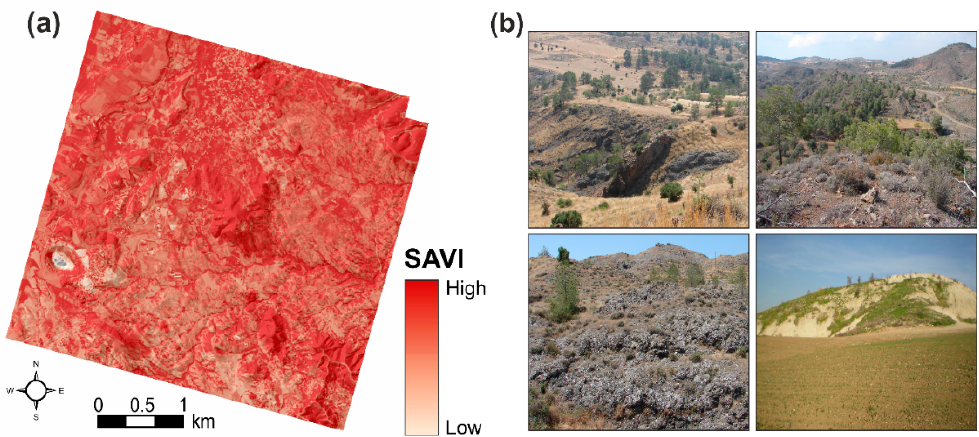
Figure 2. Widespread vegetation cover within the study area: ( a ) soil-adjusted Vegetation Index (SAVI) map indicating relative fractional vegetation abundance; and ( b ) field photographs illustrating the different types of vegetation present.